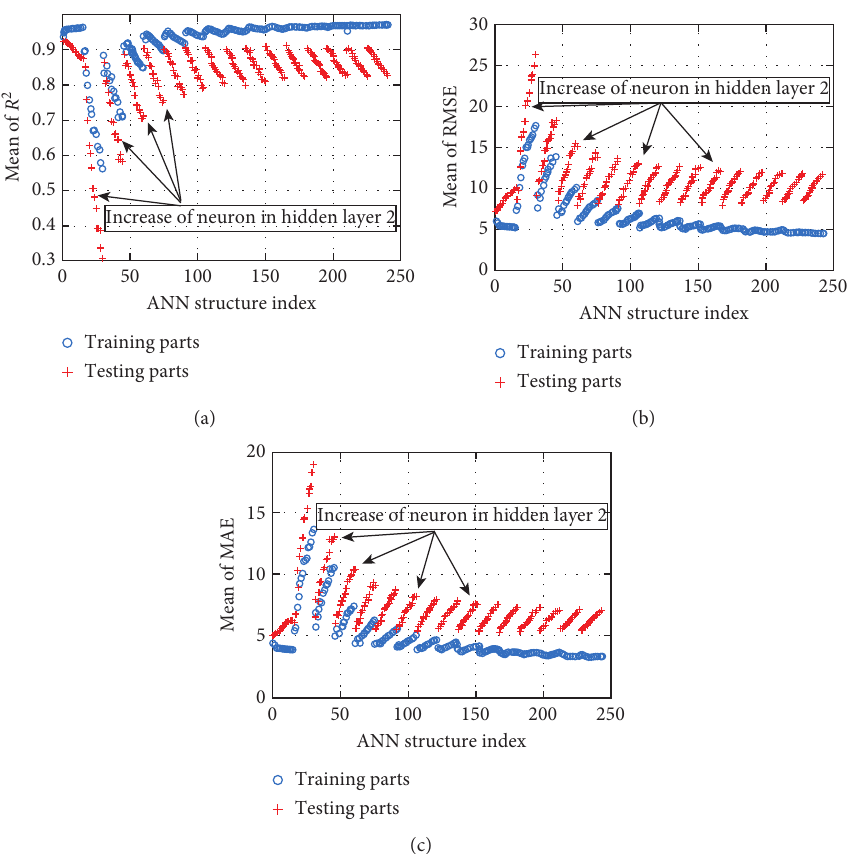
Figure 5: Performance of the ANN in the function of neuron number in 2 hidden layers, with respect to (a) mean value of R 2 for the training part, testing parts; (b) mean value of RMSE for the training part, testing parts; and (c) mean value of RMSE for the training part, testing